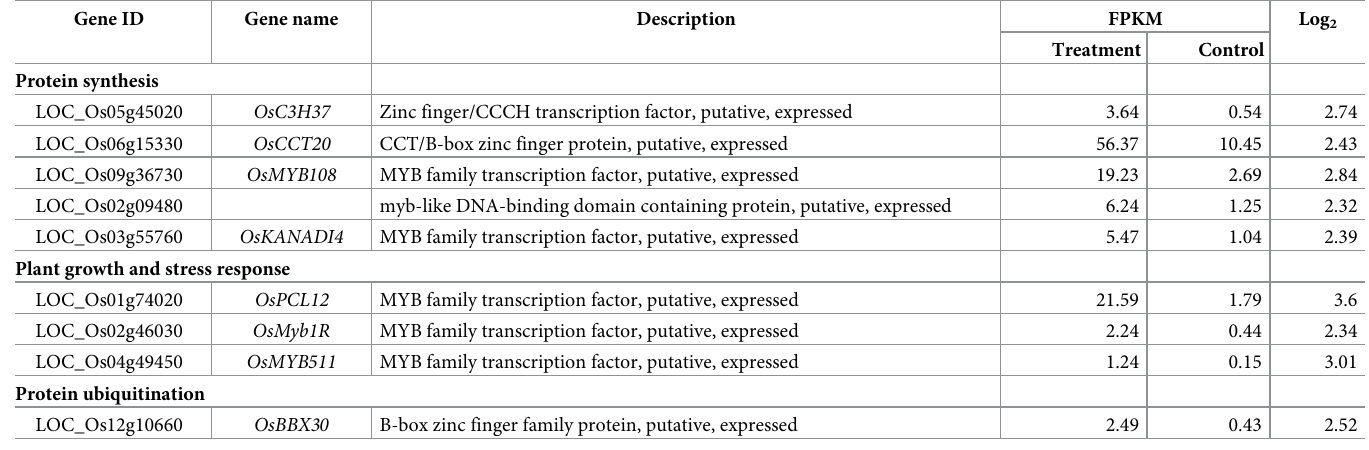
Table 4. The expression profile of upregulated transcription factor families in the 100 most differentially expressed genes in T16. Gene